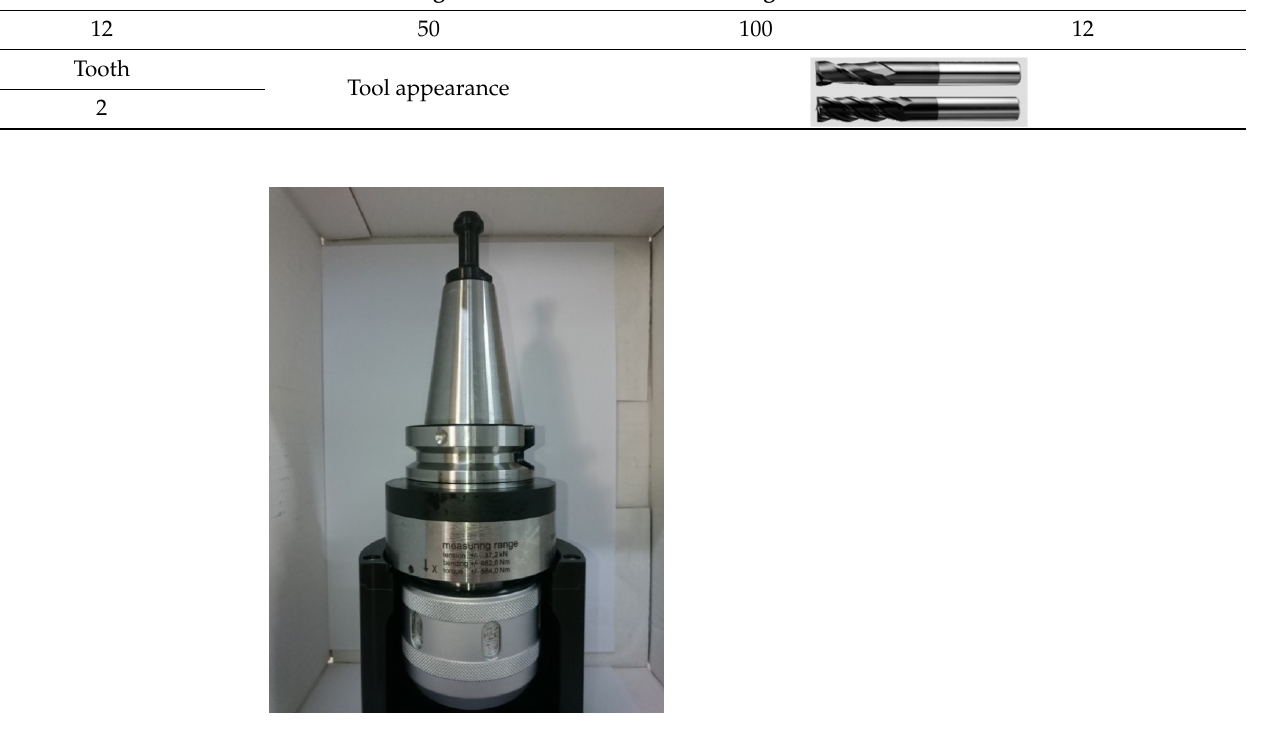
Table 1. Specifications of the Starpoint S2009 cutter.